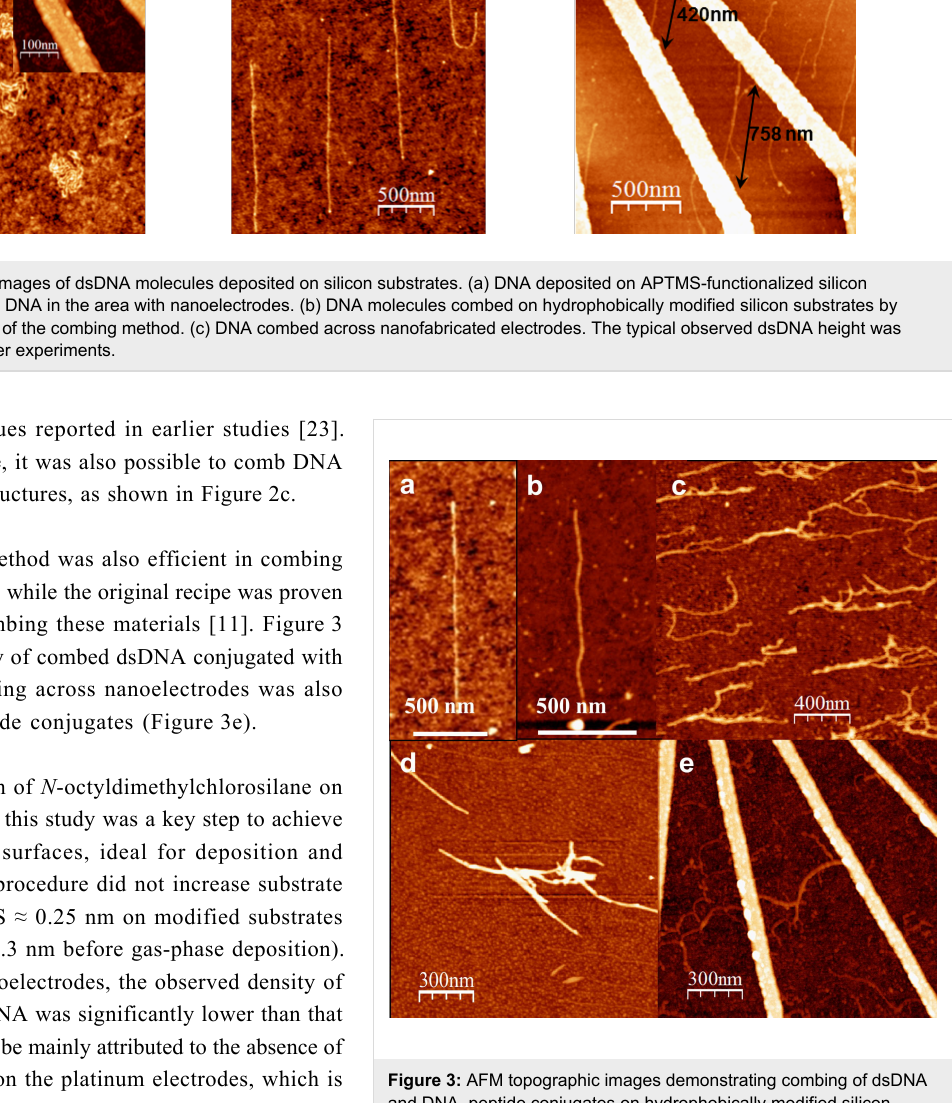
Figure 3: AFM topographic images demonstrating combing of dsDNA and DNA–peptide conjugates on hydrophobically modified silicon substrates. Vertical scale varies for different images. (a) Single dsDNA molecule, shown for comparison. (b) Single DNA–KA 6 conjugate, height 3.4 ± 0.4 nm. (c) IL-coated DNA molecules aligned in the direc- tion of combing; typical height is 2–5 nm depending on the bundle size. (d) DNA–KA 5 conjugates; typical height of a single complex 5.6 ± 0.4 nm. (e) DNA–KA 6 conjugates combed across nanoelectrodes; height 3–5 nm depending on the bundle